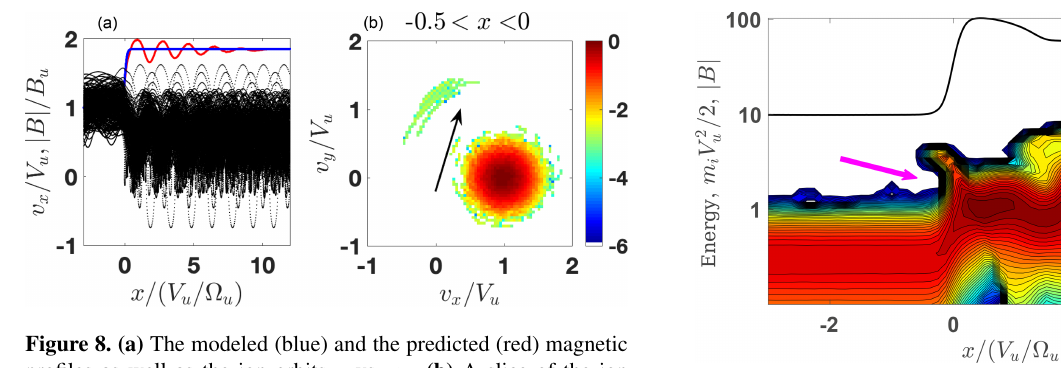
Figure 10. The gap for the shock in Fig. 8.